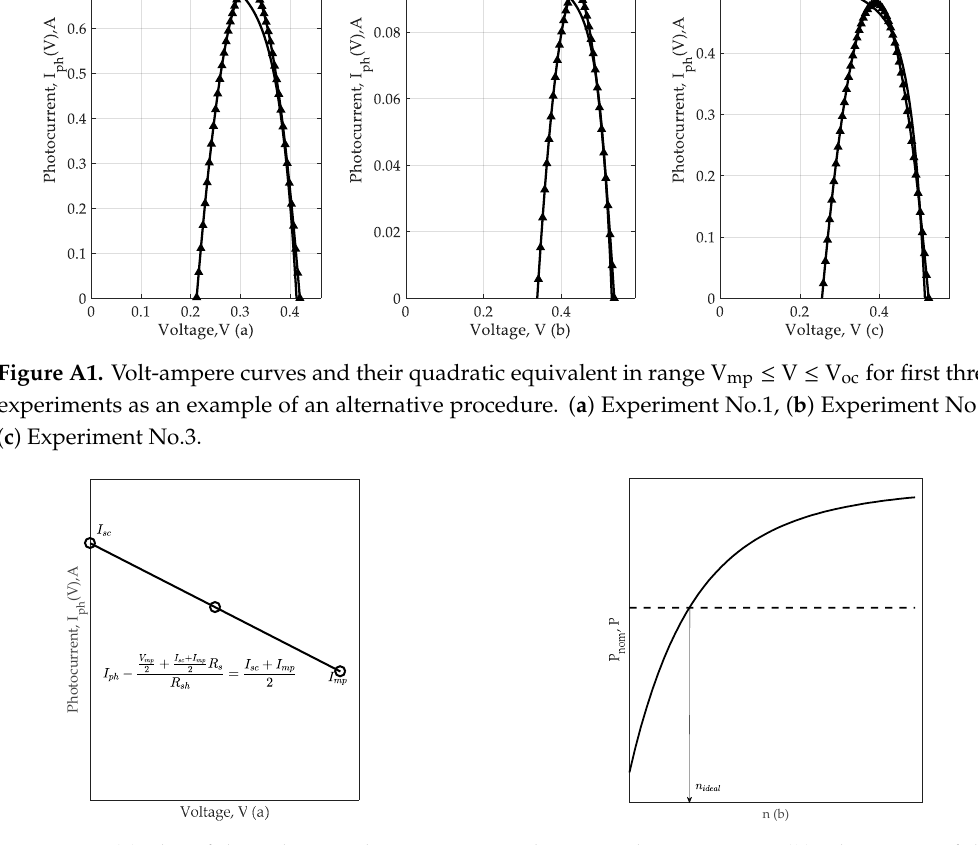
Figure A2. ( a ) Plot of the volt-watt characteristic on the interval 0 ≤ V ≤ V mp , ( b ) adjustment of the ideality factor.